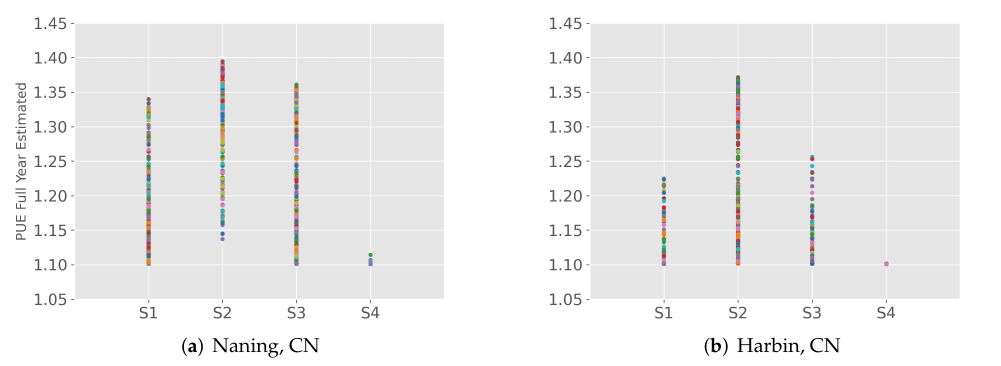
Figure 5. Typical annual PUE estimation of 2 cities in China by season.